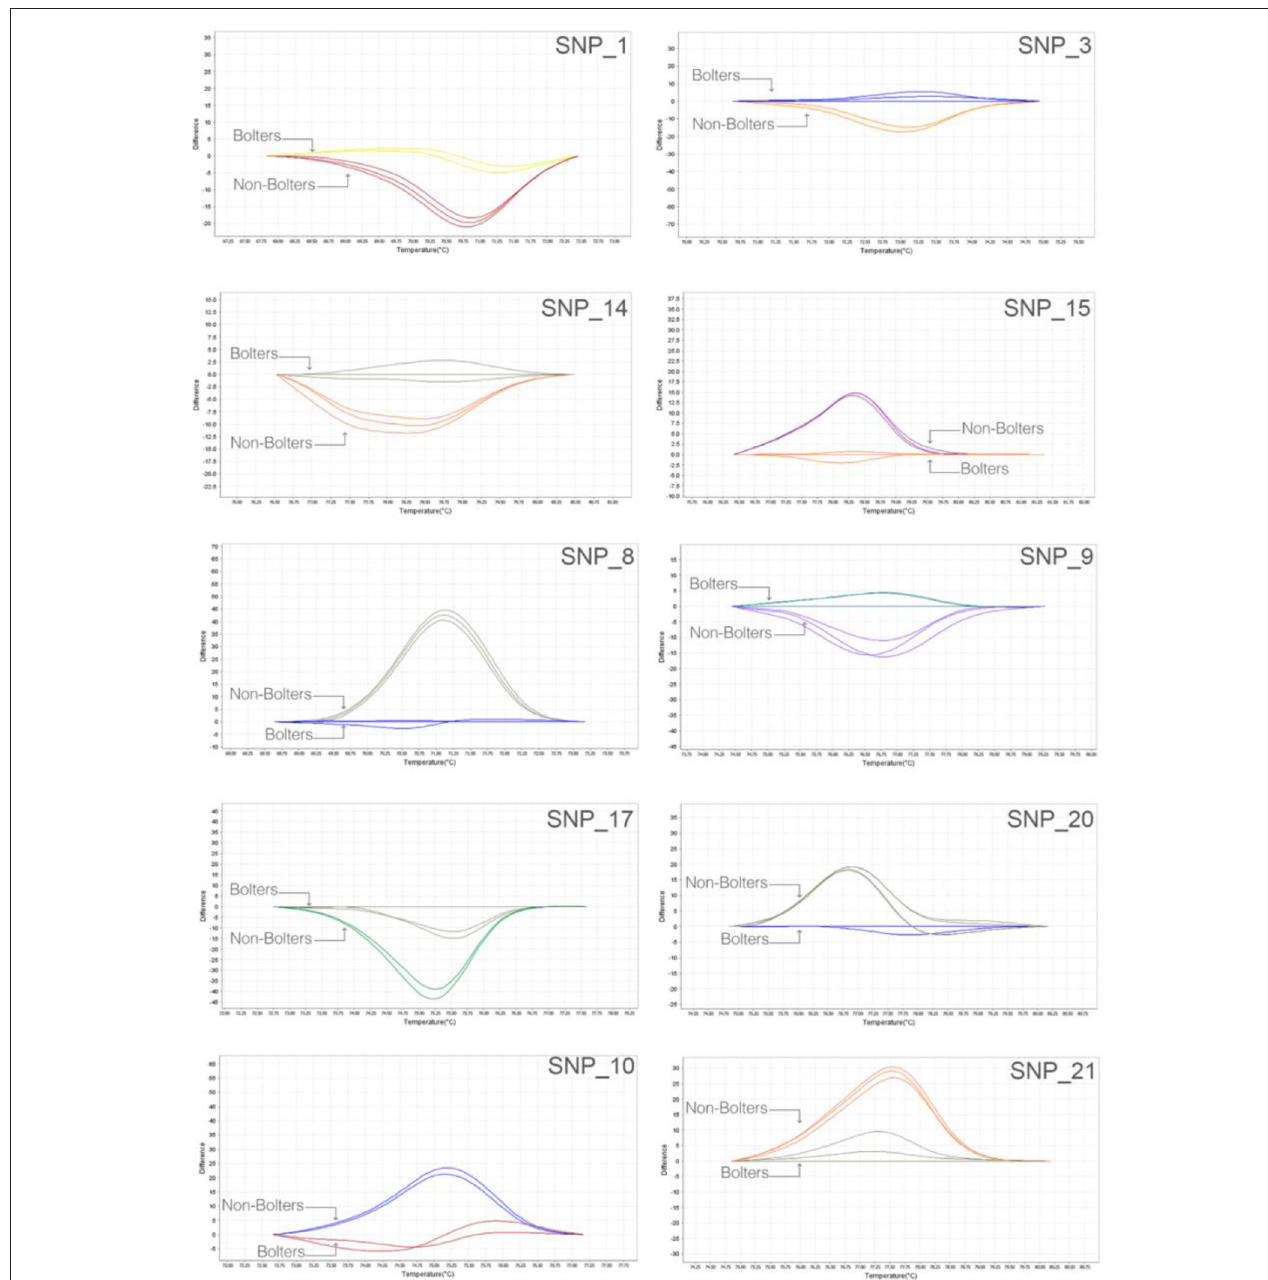
FIGURE 4 | Robust and quick SNP screening by high-resolution melting (HRM) of selected SNP targets: representative melt curve profiles discriminating three biological replicates of bolters and non-bolters from the L14 line are presented here as an example. The two different melt curve colors for each SNP target correspond to samples of bolters and non-bolters labeled